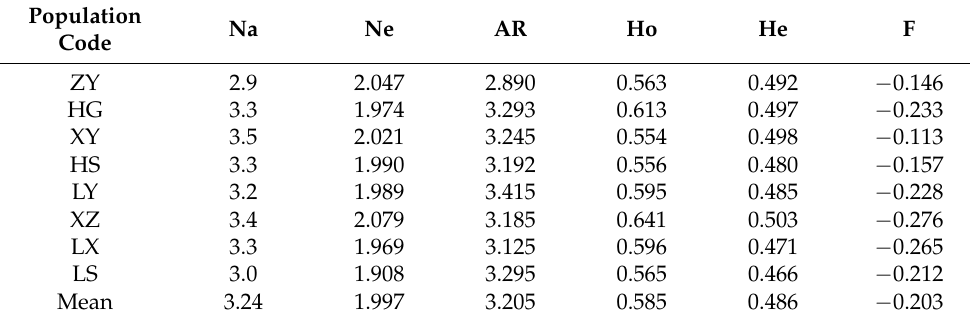
Table 4. Information on genetic diversity in the eight populations based on 10 SSR